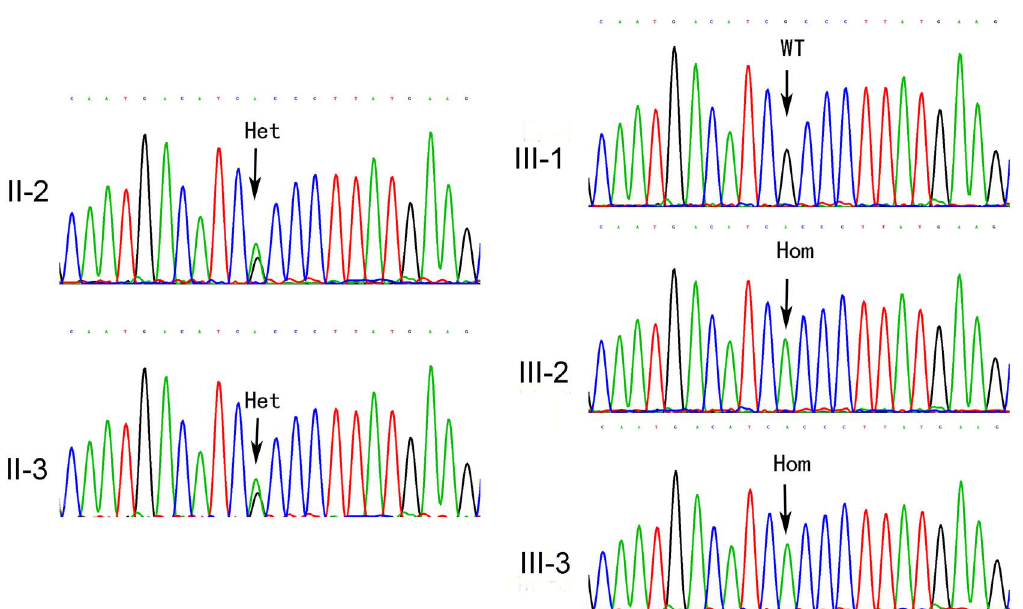
Figure 3. Data from Sanger sequencing for the two affected patients and the direct relatives in the family. Homozygous mutation genotype A/A in the two affected brothers, III-2 and III-3. Wild type genotype G/G in the unaffected sister, III-1. Heterozygous genotype G/A in both parents, II-2 and II-3.